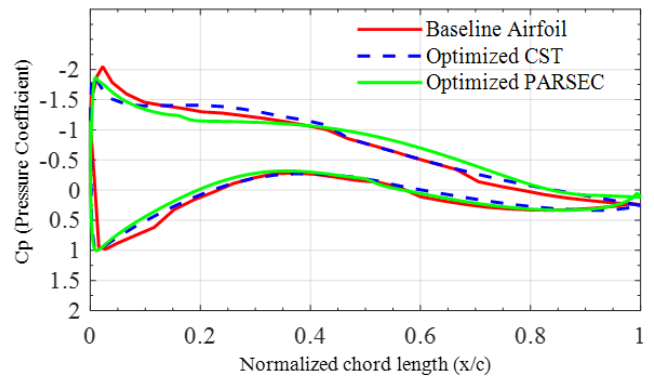
Figure 12. Pressure distribution curve over the NREL S809 airfoil.